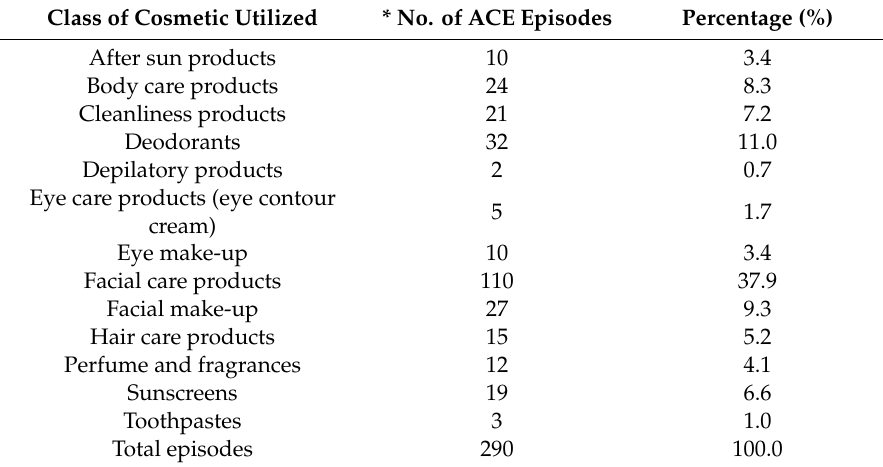
Table 5. Cosmetic adverse events stratified for cosmetic class.